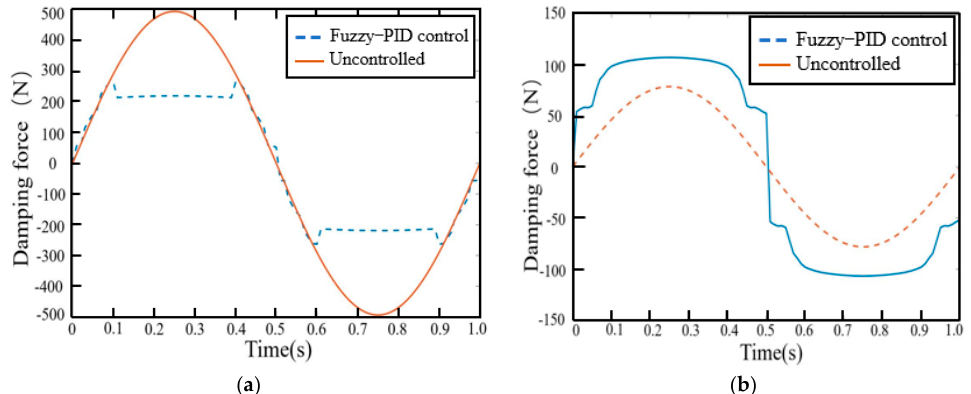
Figure 9. Damping force of fuzzy–PID control. ( a ) x -axis force tracking curve. ( b ) y -axis force tracking curve.